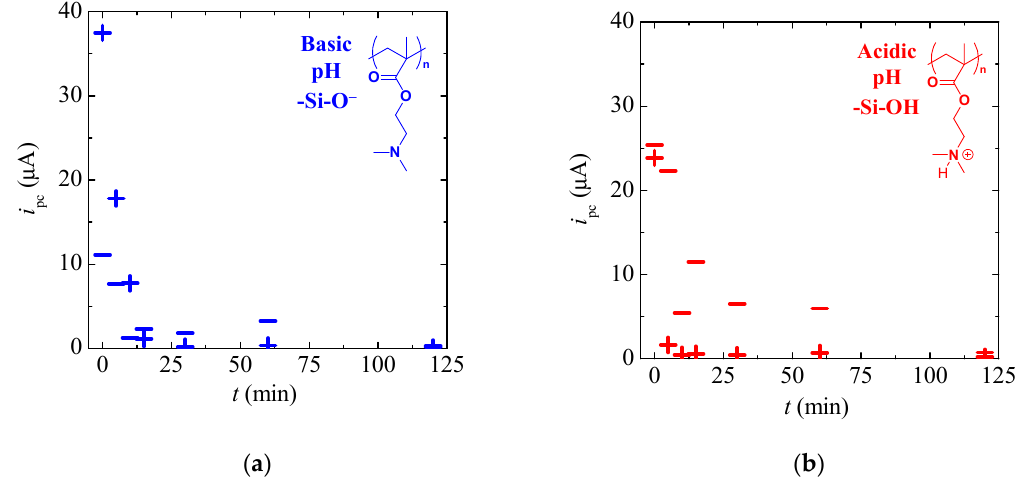
Figure 7. Ionic permselectivity with increasing polymerisation time under ( a ) basic and ( b ) acidic conditions for positive (+) and negative (–) probe molecules. Cathodic peak currents were recorded at a scan rate of 100 mV s − 1 . Reaction conditions: DMAEMA:DMF = 1:8 ( v / v ), 0–240 min, 320–400 nm, SIP confined to pores by pre-treating the 5SBDCSi films with a CO 2 plasma.